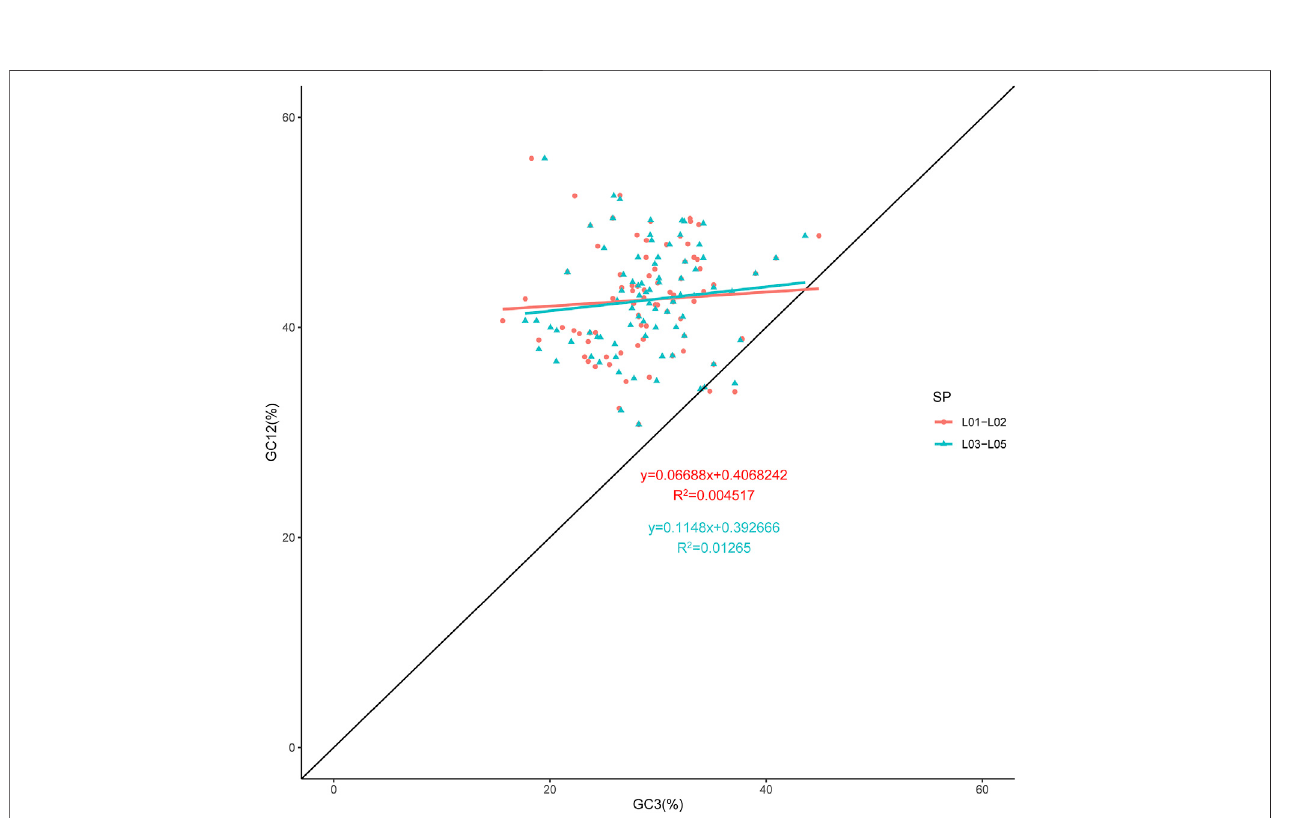
FIGURE 2 | Neutrality analysis performed by plotting GC12 values against GC3 values for the cp genomes of Thunia alba (L01 and L02) and Thuniopsis cleistogama (L03, L04 and L05). The diagonal line on the neutrality plot shows that the value of GC12 is equal to GC3.